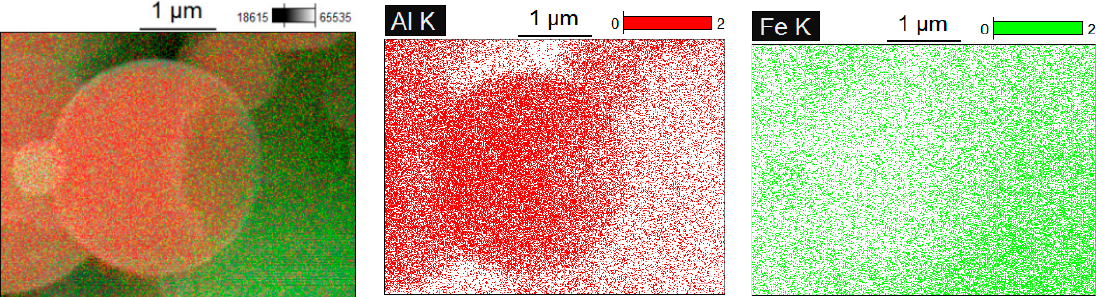
Figure 7. EDS mapping of particles with shell morphology observed in the compacts formed by Fe-40at.%Al mixtures at an early stage of chemical interaction.